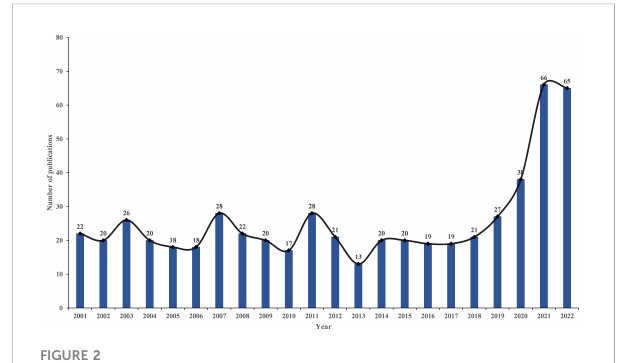
FIGURE 2 Trend of publications about the research of SAT.